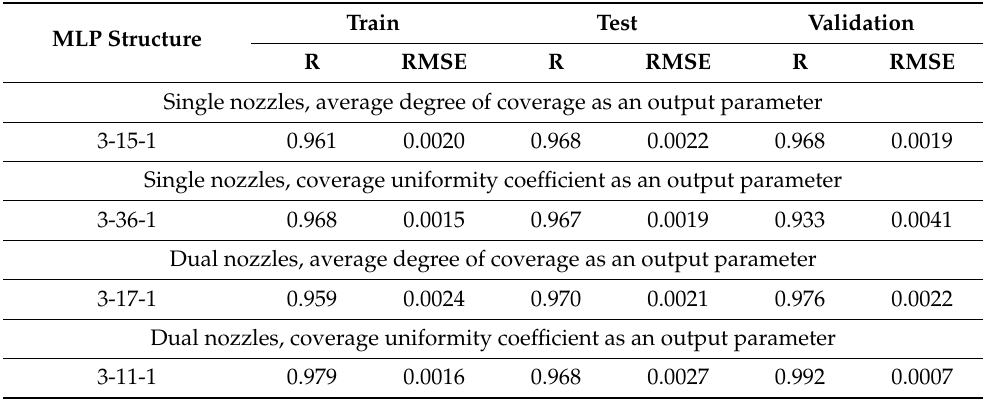
Table 2. Error metrics of best model performances. MLP